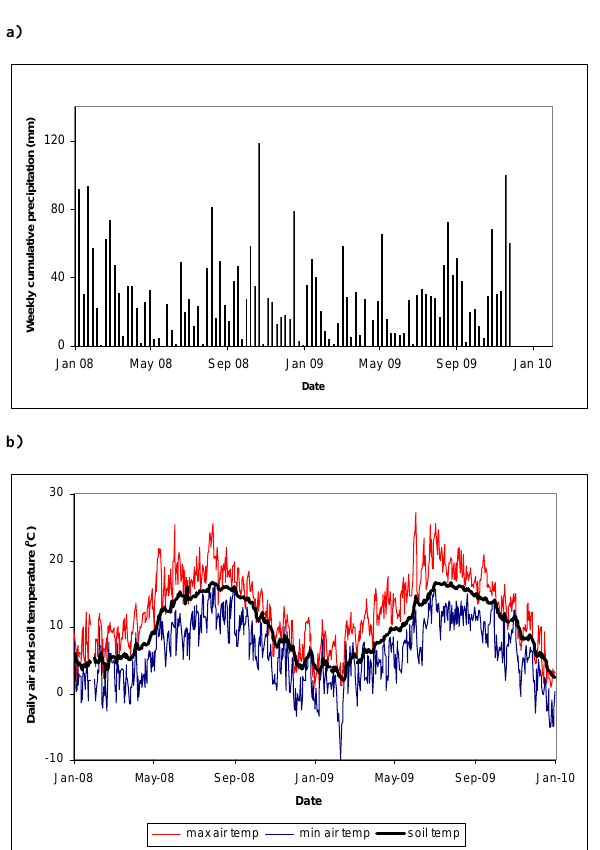
Figure 1. Environmental variables obtained from meteorological stations near Fig. 1. Environmental variables obtained from meteorological sta- Flanders Moss: a) weekly cumulative precipitation obtained from Auchentroig Estate; tions near Flanders Moss: (a) weekly cumulative precipitation ob- b) daily air and soil temperature (30 cm depth) obtained from Portnellan farm. tained from Auchentroig Estate; (b) daily air and soil temperature (30cm depth) obtained from Portnellan farm. Figure 2. Environmental variables measured at Flanders Moss during each sampling